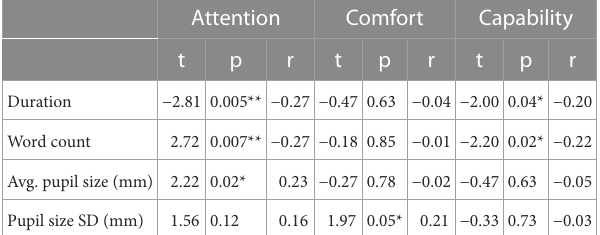
TABLE6 Pearsoncorrelationsbetweenself-reported(attention,comfort, andcapability)andbehavioralmeasures(durationandwordcount)and